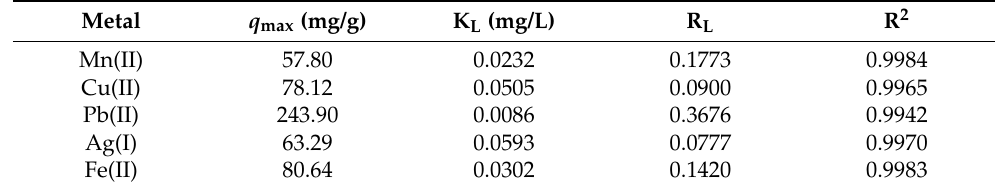
Figure 2. Adsorption of metal ions by rGO. ( A ) Effect of pH values on the adsorption capacity of Ag (I), Cu (II), Fe (II), Mn (II), and Pb (II), showing optimal adsorption at pH = 6. Metal ion concentration is 200 mg/L (ppm). ( B ) Effect of the initial concentration on the extraction of metal ions (C 0 = 5–200 mg/L, ppm). ( C ) Plot of q e versus C e and ( D ) Experimental data and the fitted Langmuir isotherm based on the plot of C e /q e versus C e . Experiment conditions. Adsorbent dose: Ag (I) = 30 mg/20 mL, Cu (II) = 20 mg/20 mL, Fe (II)=20 mg/20 mL, Mn (II) = 30 mg/20 mL, and Pb (II) = 10 mg/mL. Temperature = 25 ± 2 ◦ C, Ph = 6, contact time = 48 h. Table 1. Adsorption parameters of rGO for metal ions based on Langmuir isotherms. (Extracted from fitting of Figure 2D to Equation